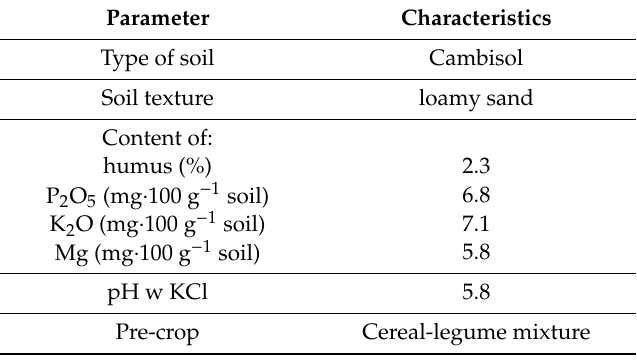
Table 1. Characteristics of the soil and habitat conditions in the experiment.